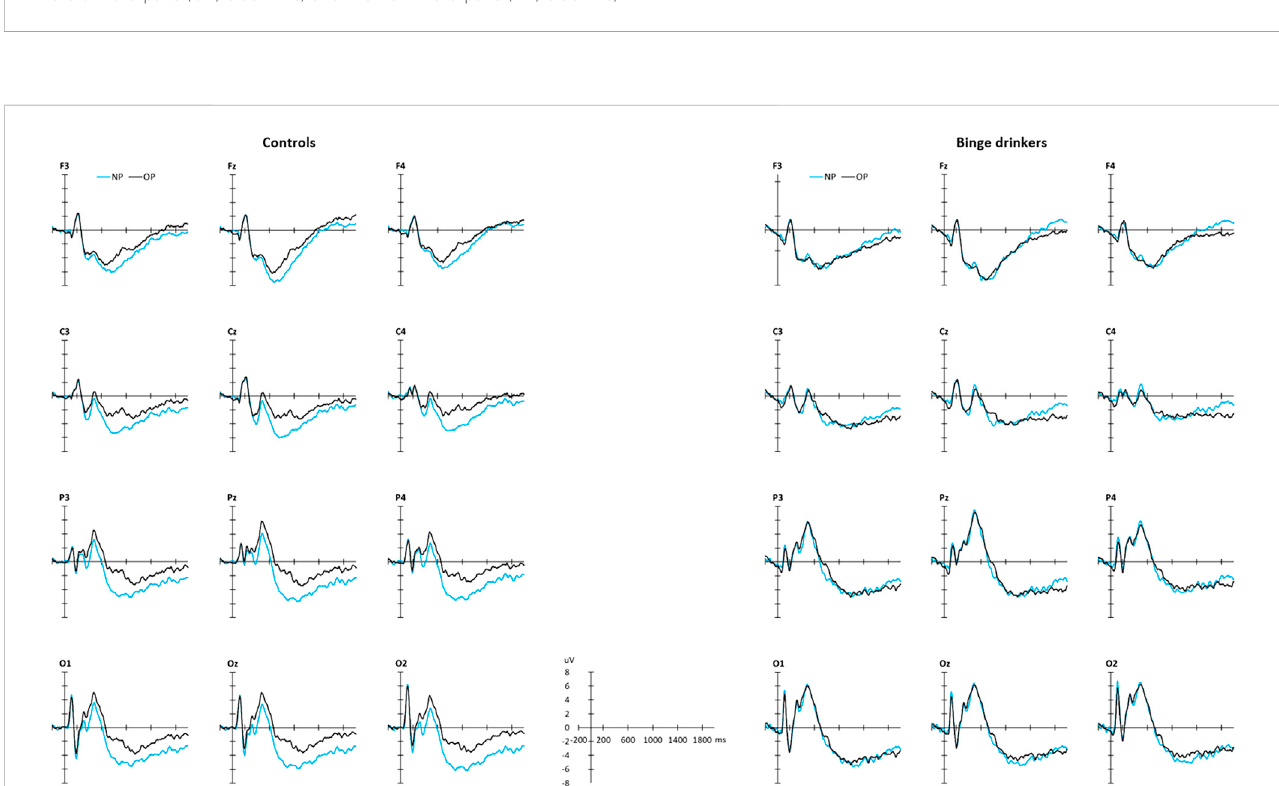
FIGURE 3 Grand average ERPs elicited by old word pairs (OP, black line) and new word pairs (NP, blue line), in a set of the recorded sites, in the control (left) and binge drinking (right) groups.